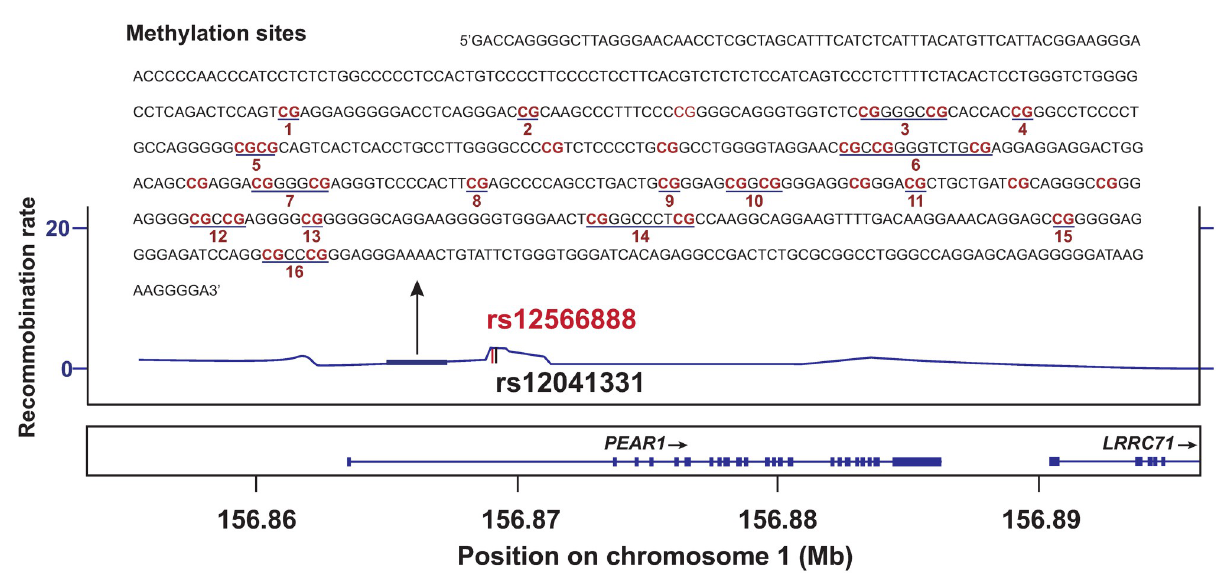
Fig 1. Plot of the PEAR1 gene (1p13.1–12.3). The x-axis represents the physical position on chromosome 1 (build 37, hg19). The y-axis and the horizontal line indicate the recombination rate. SNPs rs12566888 and rs12041331 are in complete linkage disequilibrium ( r 2 = 0.99, D’ = 1.00). The 16 CpG sites in the studied DNA sequence of the promoter (bold lines) are consecutively numbered from 1 to 16 from the 5’ to 3’ gene